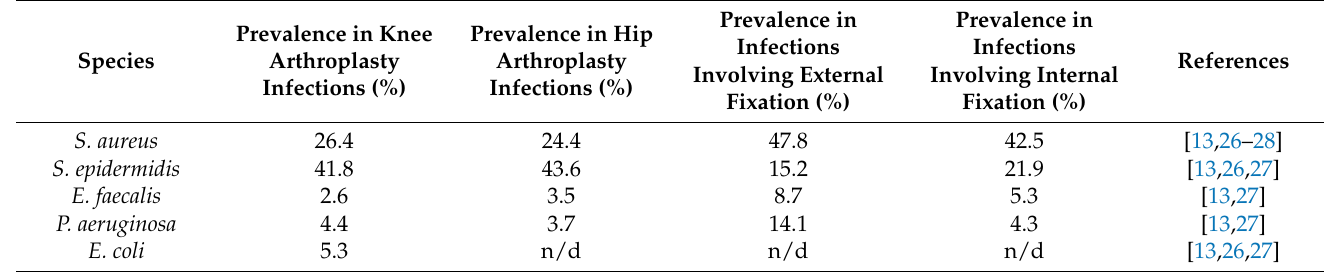
Table 1. Prevalence of implant-infecting bacteria in Europe and the U.S. according to the implant type and